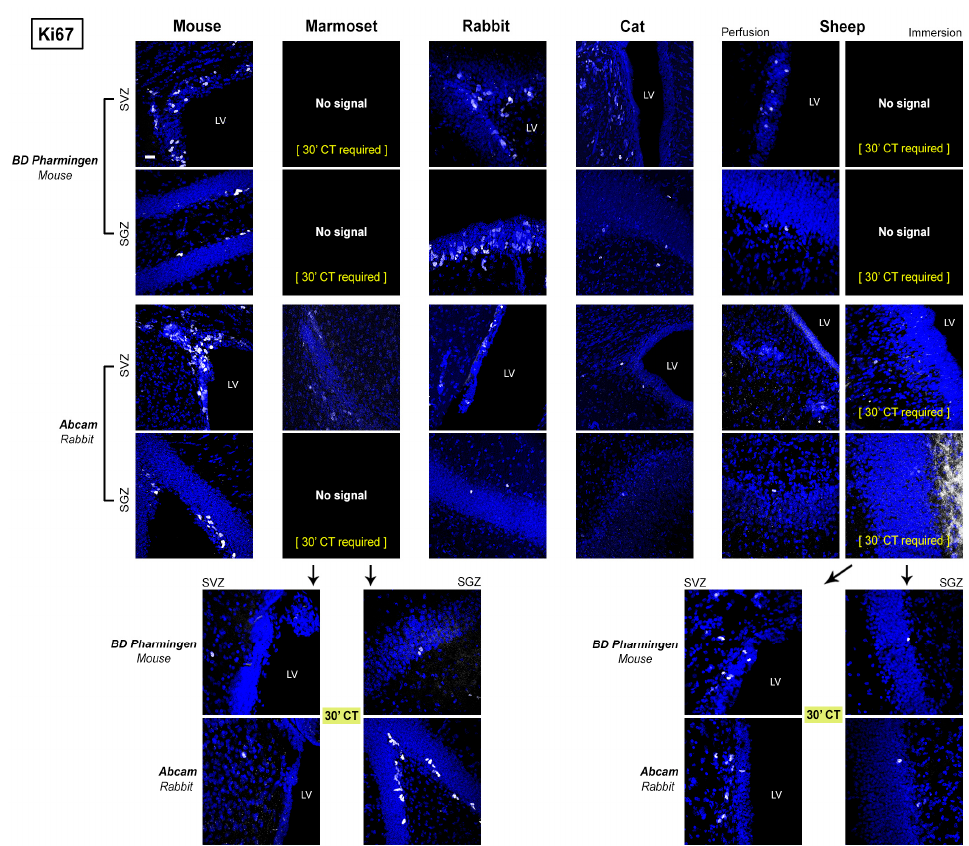
Figure 6. Representative confocal images of Ki67 antigen detection (in white) in different mammals for two different antibodies in the two neurogenic sites (forebrain SVZ and hippocampal SGZ). All specimens are counterstained with DAPI. All photographs have been performed at the same magnification (scale bar: 30 µm). In marmoset, (30 ′ CT) indicates that the antigen can be detected only after 30 min of citrate buffer treatment. LV: lateral ventricle. Table 4. ( a ) Occurrence and quality of staining for Ki67 antigen. ( b ) Merge (with and without citrate treatment).